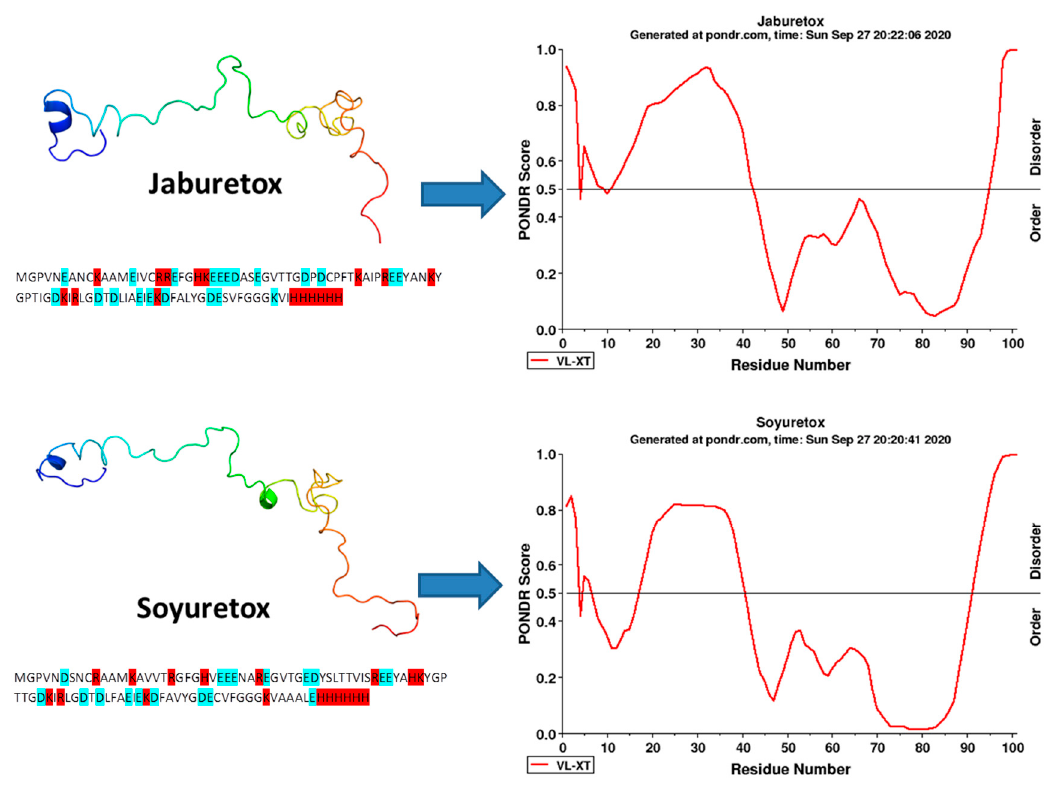
Figure 2. Disorder profile of Jaburetox and Soyuretox. Algorithm of disorder prediction VL-XT PONDR ® was applied to compare Jaburetox and Soyuretox amino acid sequences. The amino acid sequences (including the 6-His tags) were submitted to http://www.pondr.com/ to generate the graphics. PONDR score above 0.5 indicates disorder. Jaburetox is slightly more disordered than Soyuretox, especially in its N-terminal region. Jaburetox structure is based on conformer 1 (PDB 2MM8). The modeled structure of Soyuretox was obtained with Modeller 9.19 using Jaburetox as a model. The primary sequences of the peptides appear below each 3D-structure, negatively charged amino acids are highlighted in blue and positively charged in red.